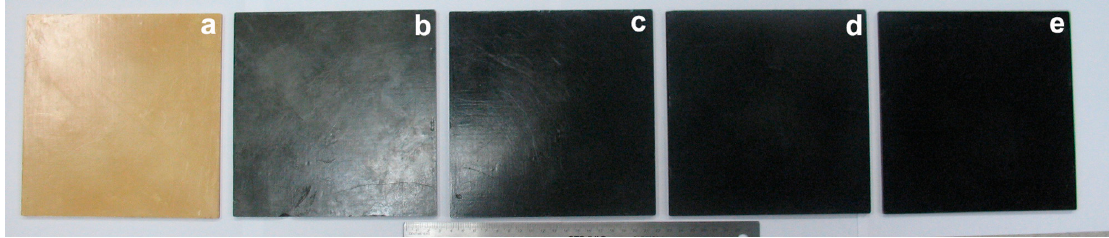
Figure 2. Photographs of the nanocomposite bioplastics: ( a – e ) 0.0, 0.1, 0.5, 1.0, and 2.0 wt %, respectively.